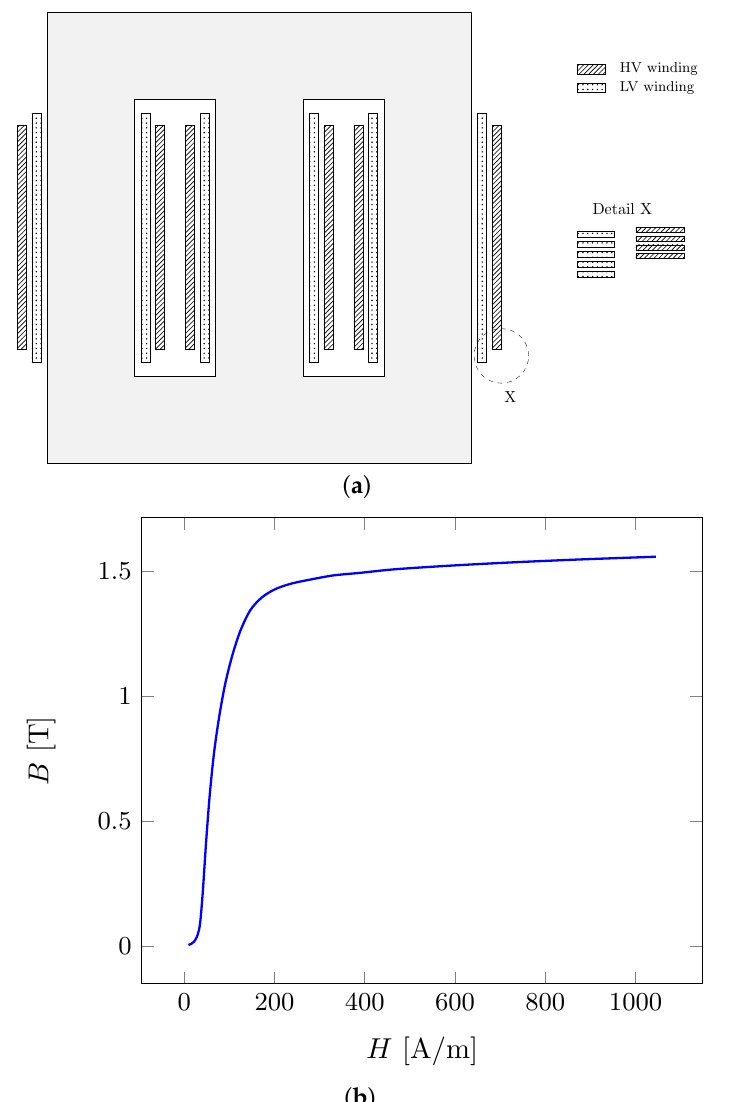
Figure 1. Power transformer characteristics. ( a ) Internal structure; ( b ) Core saturation